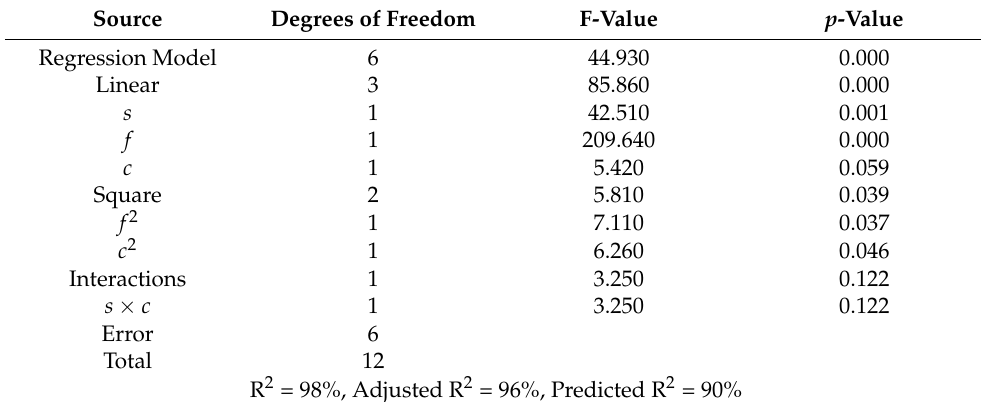
Table 4. Regression analysis of variance for average surface roughness.